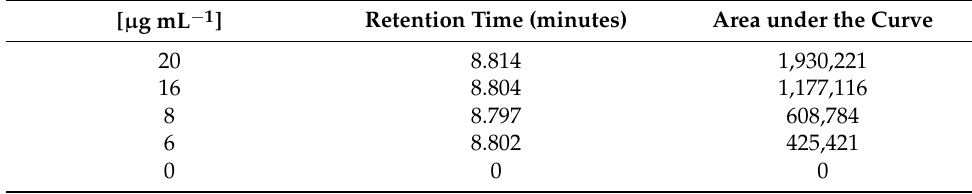
y = 91585x - 87537 R² = 0.9618